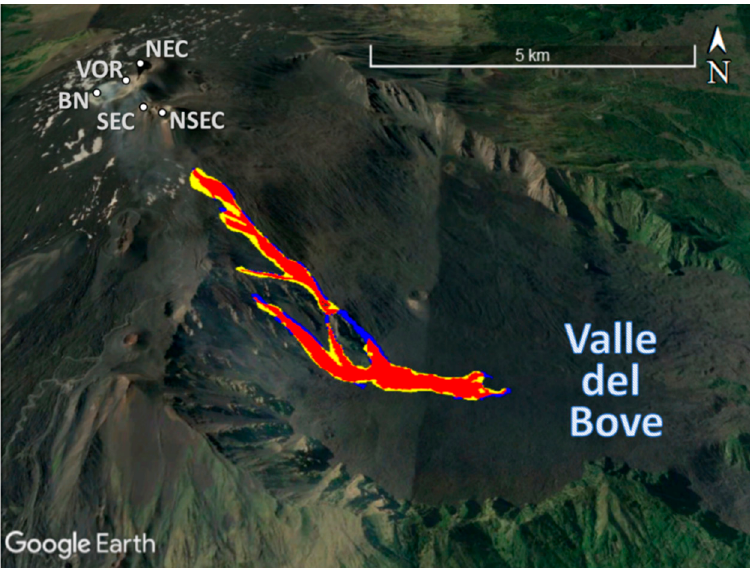
Figure 5. Combined outcome from all the classifiers: true positive (red area), false positive (yellow area) and false negative (blue area). North-East Crater (NEC), Voragine (VOR), Bocca Nuova (BN), South-East Crater (SEC), and New South-East Crater (NSEC) are the summit craters of Etna. Valle del Bove is the large depression on the eastern flank of the volcano. This figure was generated using Google Earth. Table 3. Areal extent of lava flow field of the 2018 Etna eruption estimated by machine learning classifiers using S1, S2, L8, fused and combined data. The performance indices ACC, PPV, and TPR, ranging between 0 (worst case) and 1 (best case), quantify the goodness of fit with the actual lava flow area.